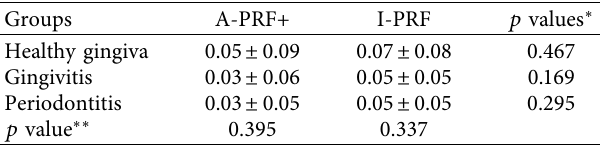
Table 3: Mature bioflm impact assay: the percent reduction in the number of bacteria (%) compared to the control under the in- fuence of diferent blood-derived products (A-PRF+ and I-PRF) from the three